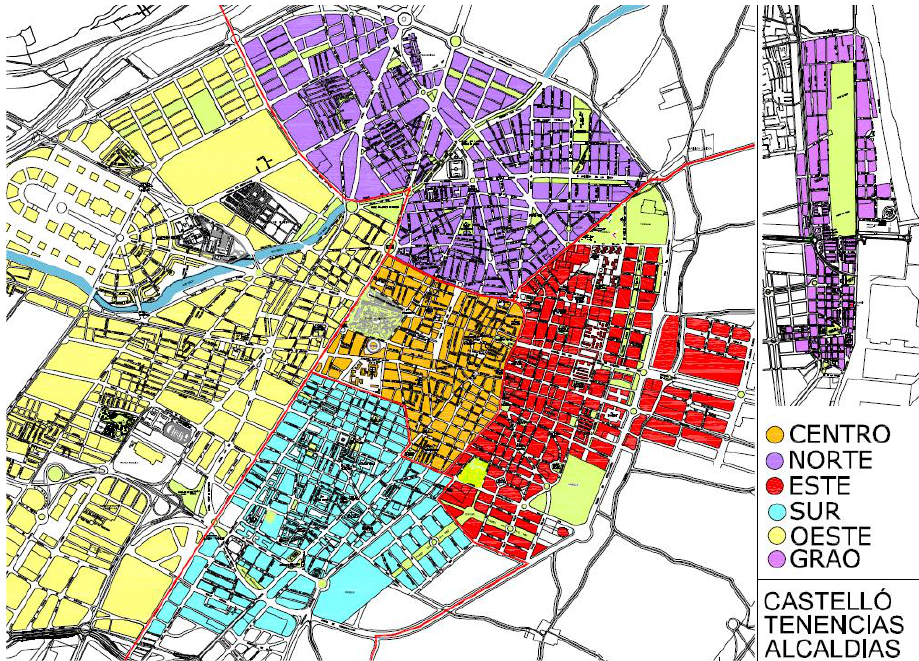
Figure 1. Castellón map with districts (39°59.1402 ′ N, 0°2.961′ W). Adapted with permission from Figure 1. Castell ó n map with districts (39 ◦ 59.1402 (cid:48) N, 0 ◦ 2.961 (cid:48) W). Adapted with permission from Ayuntamiento de Castelló de la Plana [44]. Ayuntamiento de Castell ó de la Plana